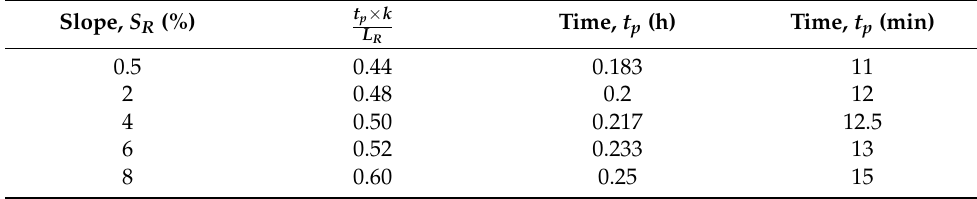
Table 8. Results of the time taken for water flow over the PFC pavement surface, t p. Slope, S R